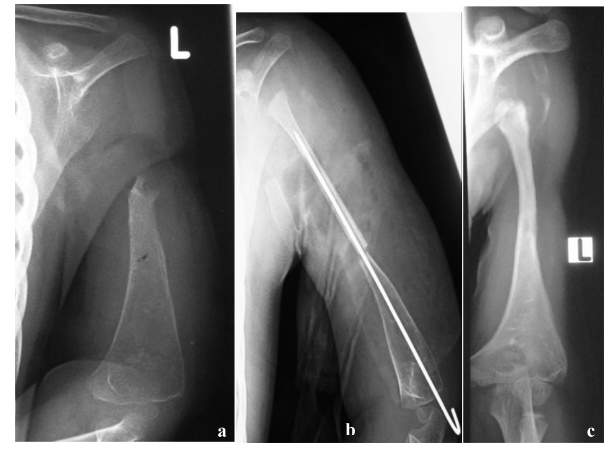
Figure 3. (a) Radiograph at presentation of a 3-year-old child re- ferred for a possible shoulder disarticulation; (b) a proximal fibu- lar epiphysis was used for bone and joint reconstruction; (c) radio- graph taken 6 years later demonstrates reconstruction of the prox- imal half of the humerus, with an expanded and more spherical pseudo-humeral